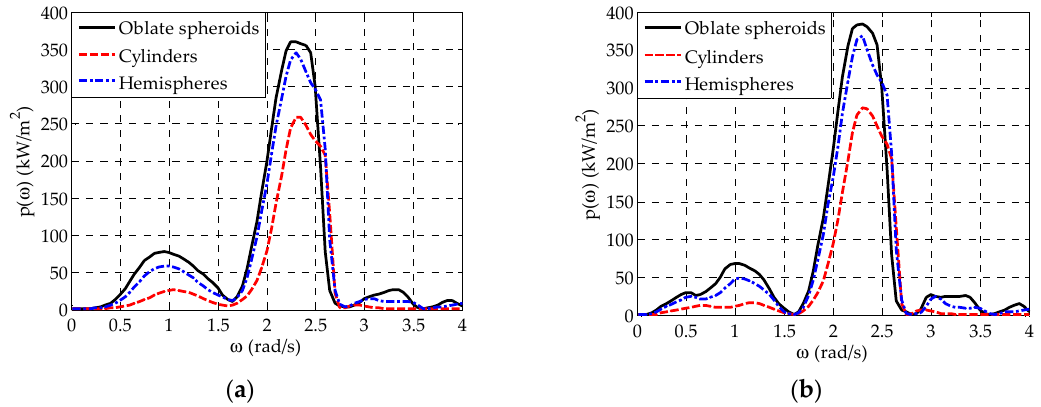
Figure 6. Comparison of p ( ω ) for arrays with di ff erent WEC geometries: ( a ) l w / a = 18 and ( b ) l w / a = 72 ( c = 6 m, l bet / a = 4 for both l w / a cases).